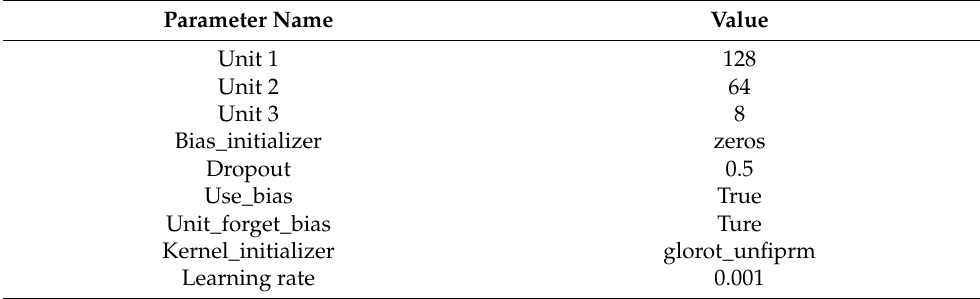
Table 3. Partial parameter settings for the Tea Plantation Data Prediction Model.